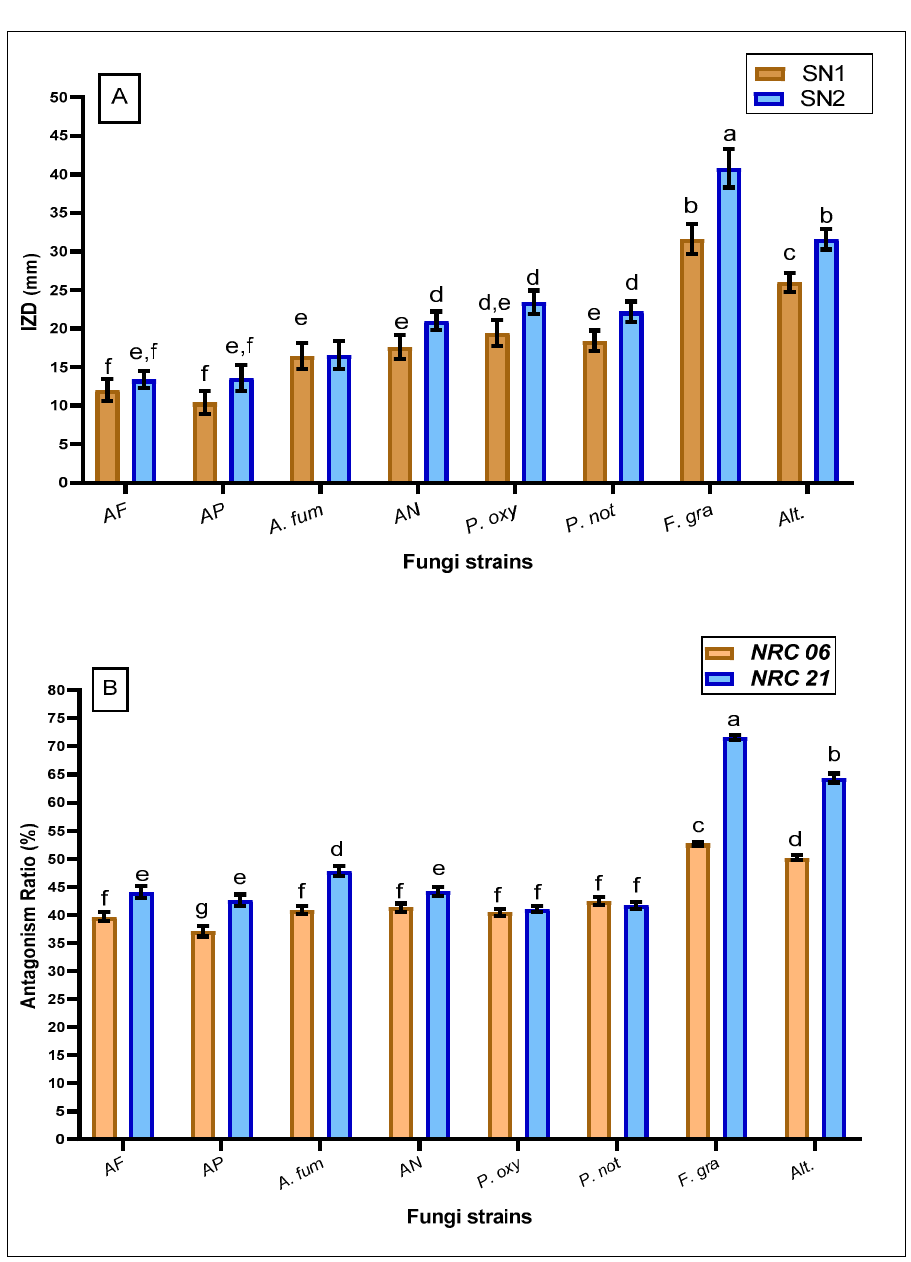
Figure 2. Antifungal activity of applied probiotic strains against toxigenic fungal strains. ( A ) Antifungal activity evaluated with bacterial supernatants determined according to zone inhibition diameter. ( B ) Antifungal activity of bacterial cells determined according to antagonistic ratio (%). For each of the ( A , B ), the columns with different superscript letters show significantly differences. SN1: supernatant of L. acidophilus NRC06; SN2: supernatant of L. plantarum NRC21; NRC06: bacterial cells of L. acidophilus NRC06; NRC 21: bacterial cells of L. plantarum NRC21. AF: Aspergillus flavus ; AP: A. parasiticus ; A. fum: A. fumigatus ; AN: A. niger ; P. oxy: Penicillium oxysporium ; P. not: P . notatum ; F. gra: Fusarium graminarum ; Alt: Alternaria alternata